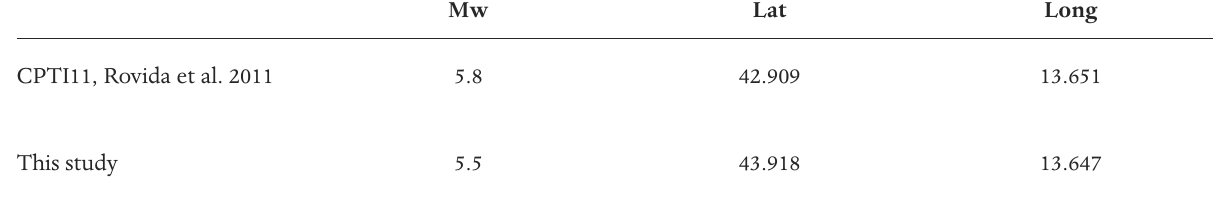
Table 4. Final earthquake parameters computed after this study, in comparison with the previous one quoted in the latest version of the CPTI11 Catalogue in Rovida et al.